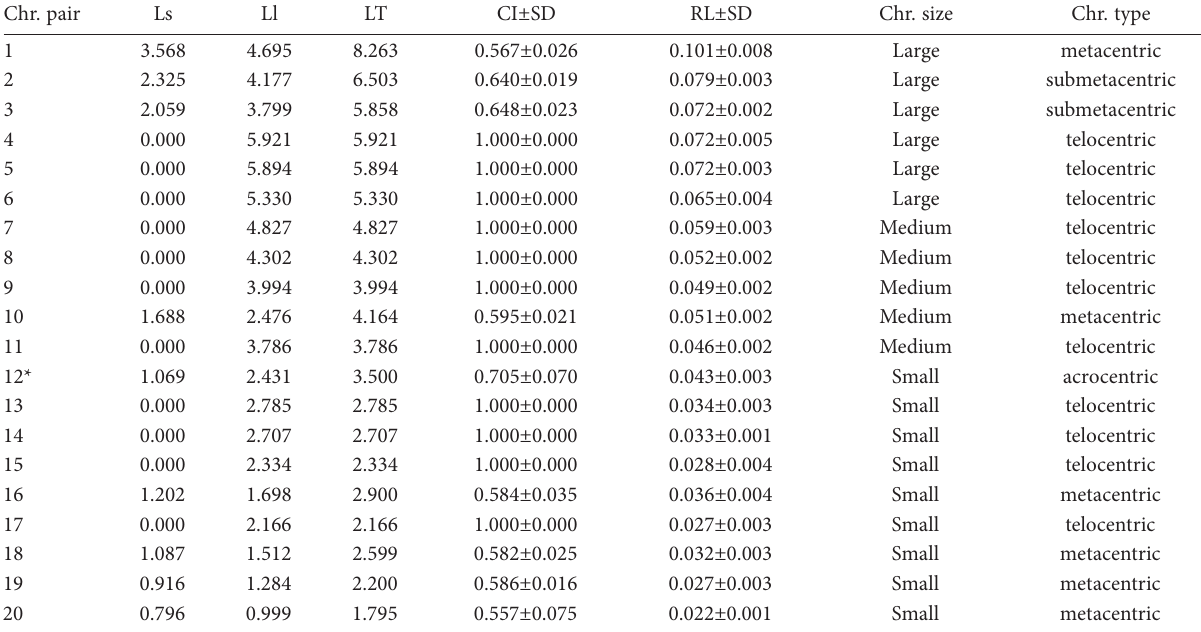
Table 2. Mean length of short arm chromosome (Ls), length of long arm chromosome (Ll), length of total chromosomes (LT), relative length (RL), centromeric index (CI) and standard deviation (SD) from 10 metaphases of male and female Cyrtodactylus inthanon , 2 n =40. Chr.